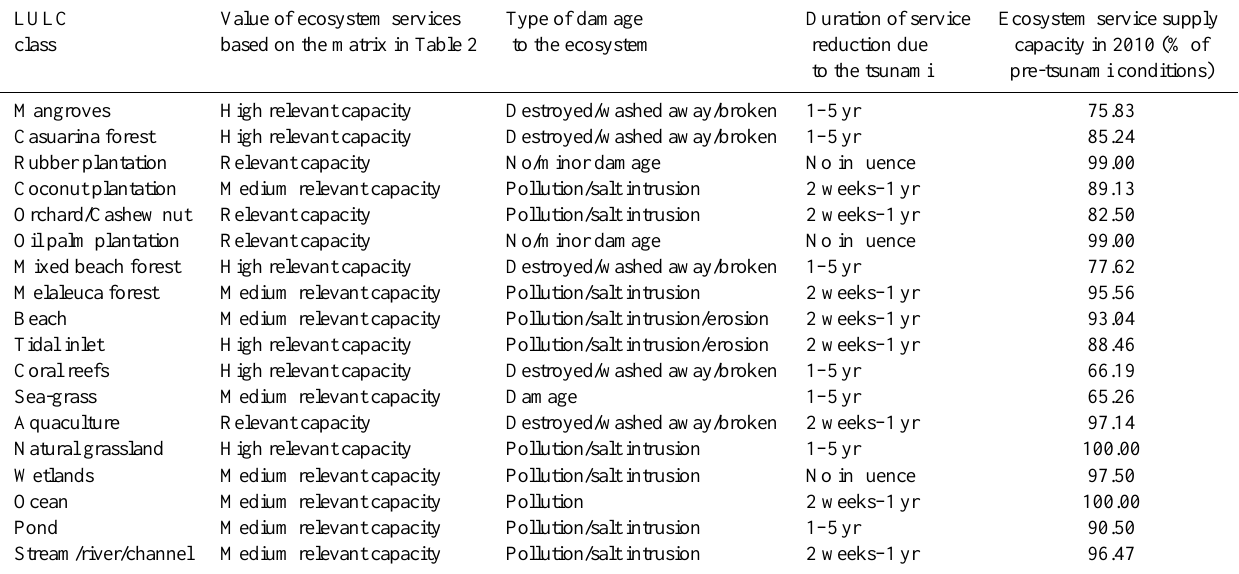
Table 4. Damage and recovery of ecosystem service supply capacities due to the tsunami. The values of the ecosystem services by LULC class are derived from the matrix in Table 2. Type of damage and recovery and duration of service reduction were derived from stakeholder interviews using the statistical median for all answers (modified from Haitook et al.,